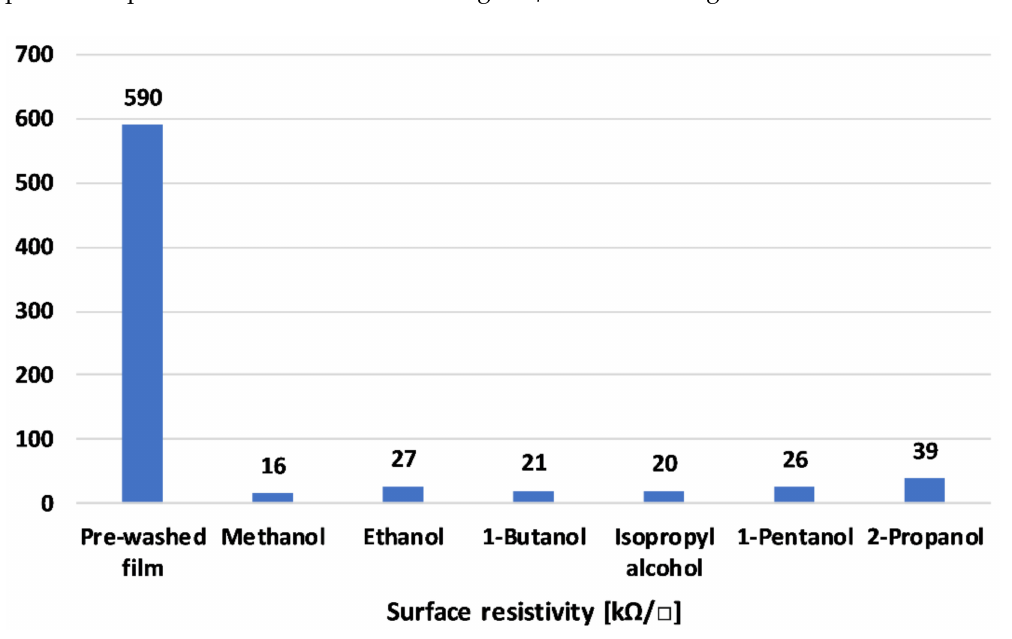
Figure 1. Film resistivity with di ff erent solvents